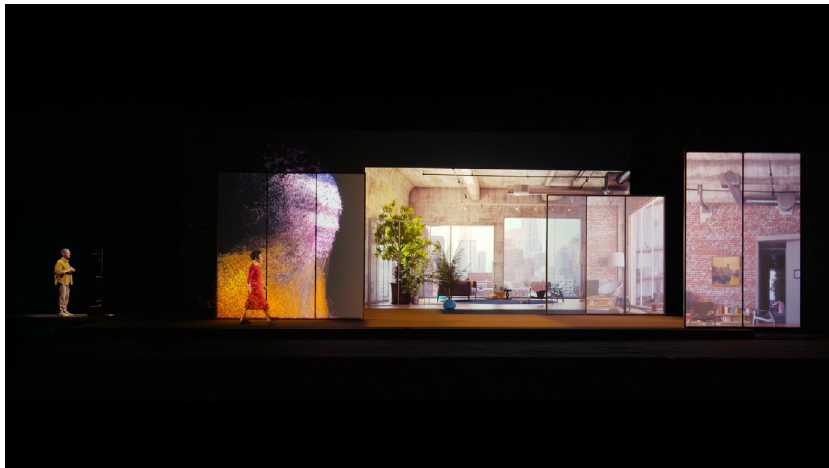
Fig. 1 – Roderick Williams and Julia Bullock as father and daughter. Michel van der Aa, Upload , still